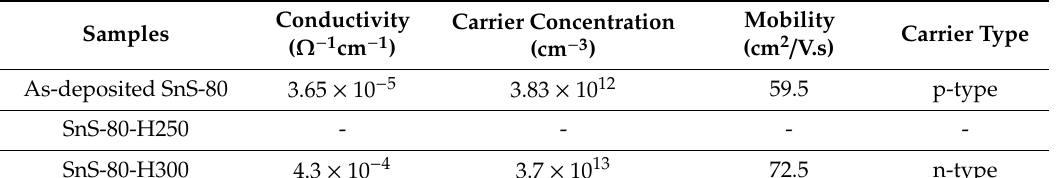
Table 2. Summaries of the electrical properties of various SnS thin films as obtained by Hall effect measurement.